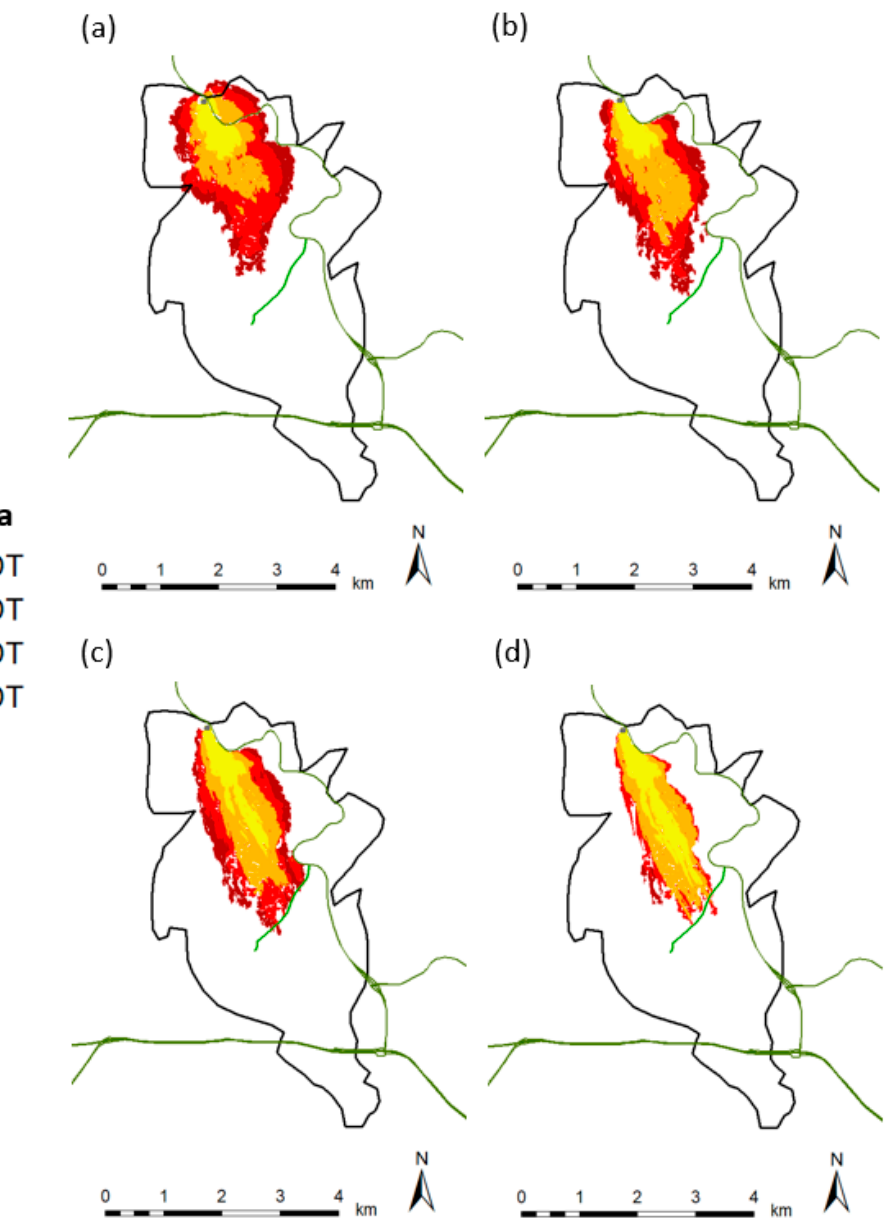
Figure 7. Painted Cave fire ignition site (light grey dot), official fire perimeter (black polygon), and simulated burn areas (colored polygons) for ( a ) GF 1.0, ( b ) GF 1.4, ( c ) GF 1.7, and ( d ) GF 2.0. The green lines indicate important reference roads; the dark green line in the southern part of the fire perimeter is Highway 101, the dark green line in the eastern part of the fire perimeter is Highway 154, and the light green line in the middle of the perimeter is San Antonio Creek Rd.